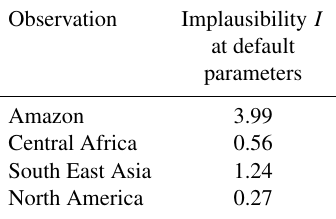
Table 2. Implausibility I of forest observations at default input pa- rameter setting of